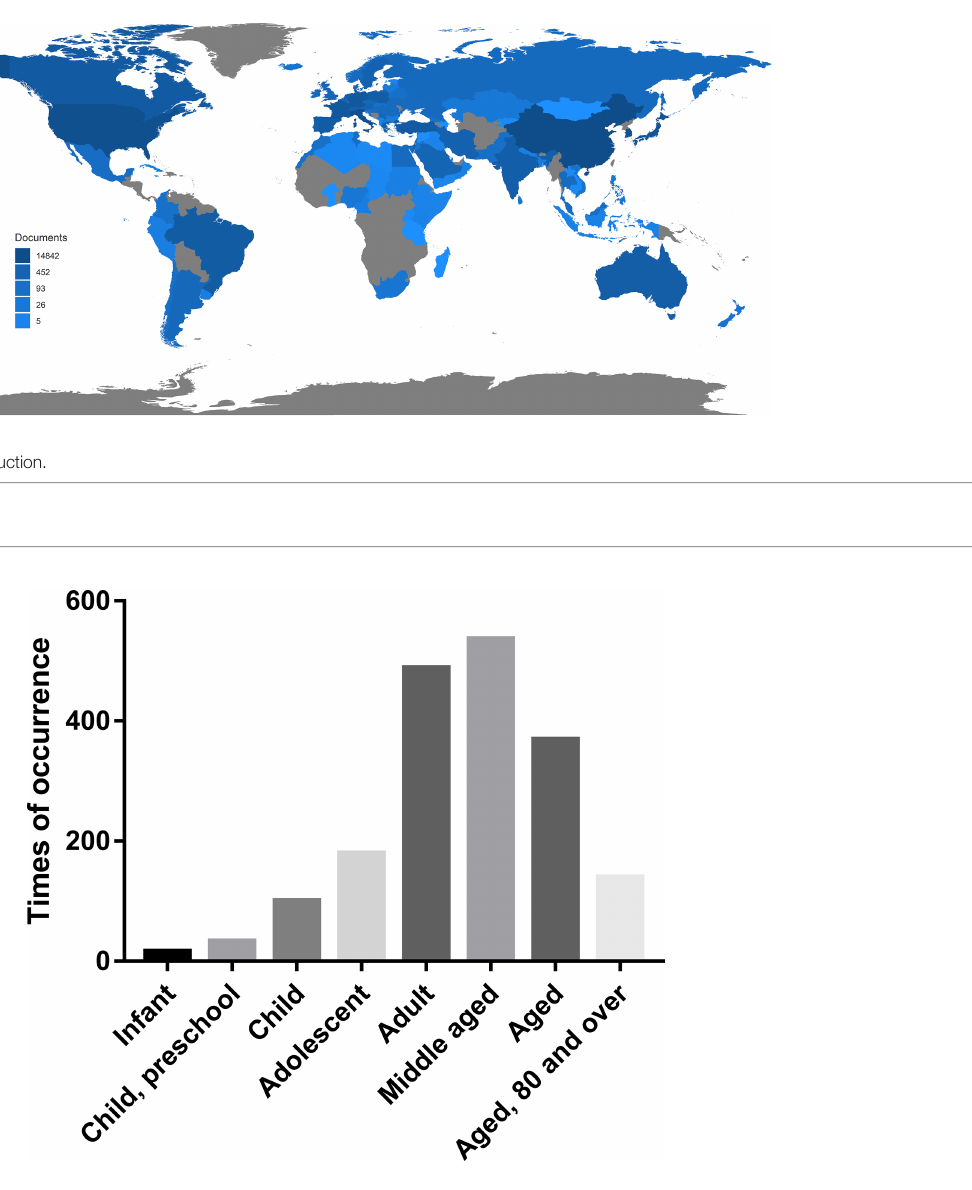
FIGURE 3 | The mean times of occurrence of MeSH terms concerning age per year.